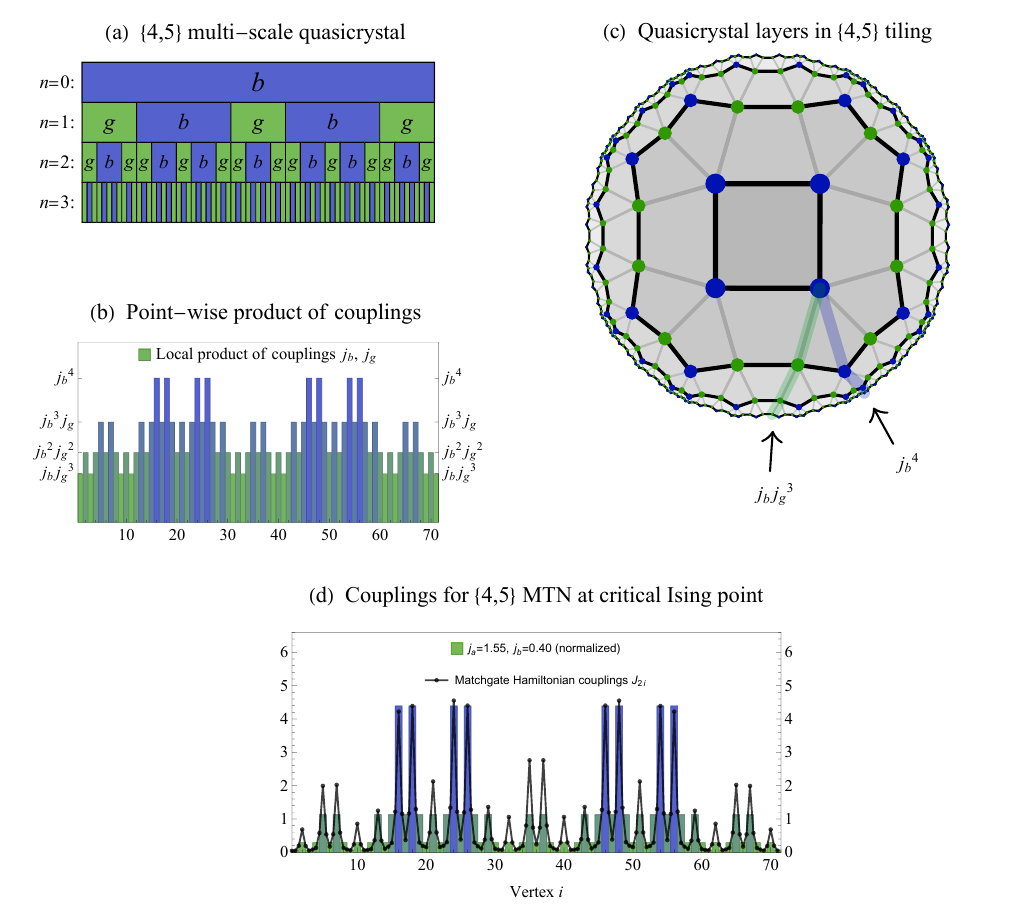
Figure 19 . Construction of a multi-scale quasicrystal ansatz (MQA) for coupling sequences of the { 4 , 5 } tiling. (a) The MQA of ref. [37] composed of inflation layers following the rule (D.1). (b) A point-wise (vertical) product of couplings j l corresponding to each letter l ∈ ( g, r ) of the inflation sequence. Each bar corresponds to the product of blocks directly above it in (a). (c) The inflation layers embedded into the { 4 , 5 } tiling, with the path between layers highlighted for three point-wise products. (d) For a suitable choice of the j l the couplings closely reproduce the effective Hamiltonian couplings for the { 4 , 5 } MTN states at the critical Ising point. The couplings are shown normalized so that h v i = 1